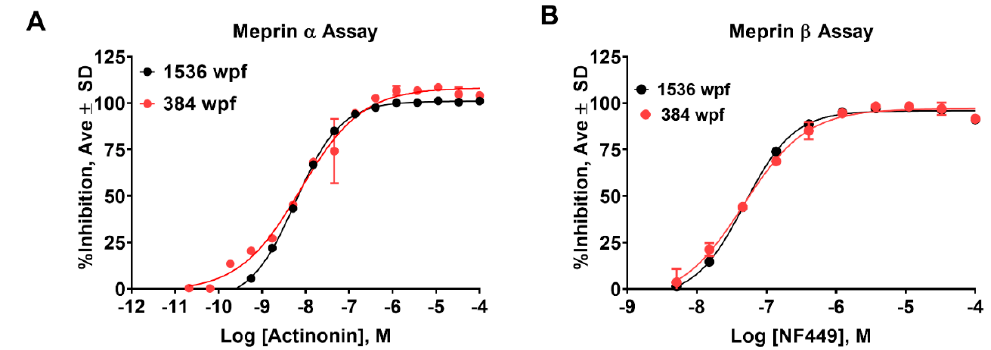
Figure 2. Assay recapitulation in 1536 well plate format. Concentration response studies in 384 and 1536 well plate formats showed similar potency of pharmacological controls for ( A ) meprin α (actinonin) and ( B ) meprin β (NF449) assays. Both assays were performed in triplicate. Table 1. Comparison of meprin α and meprin β assay parameters in 384 and 1536 well plate formats. Assay S/B Z’ Actinonin IC 50 ,